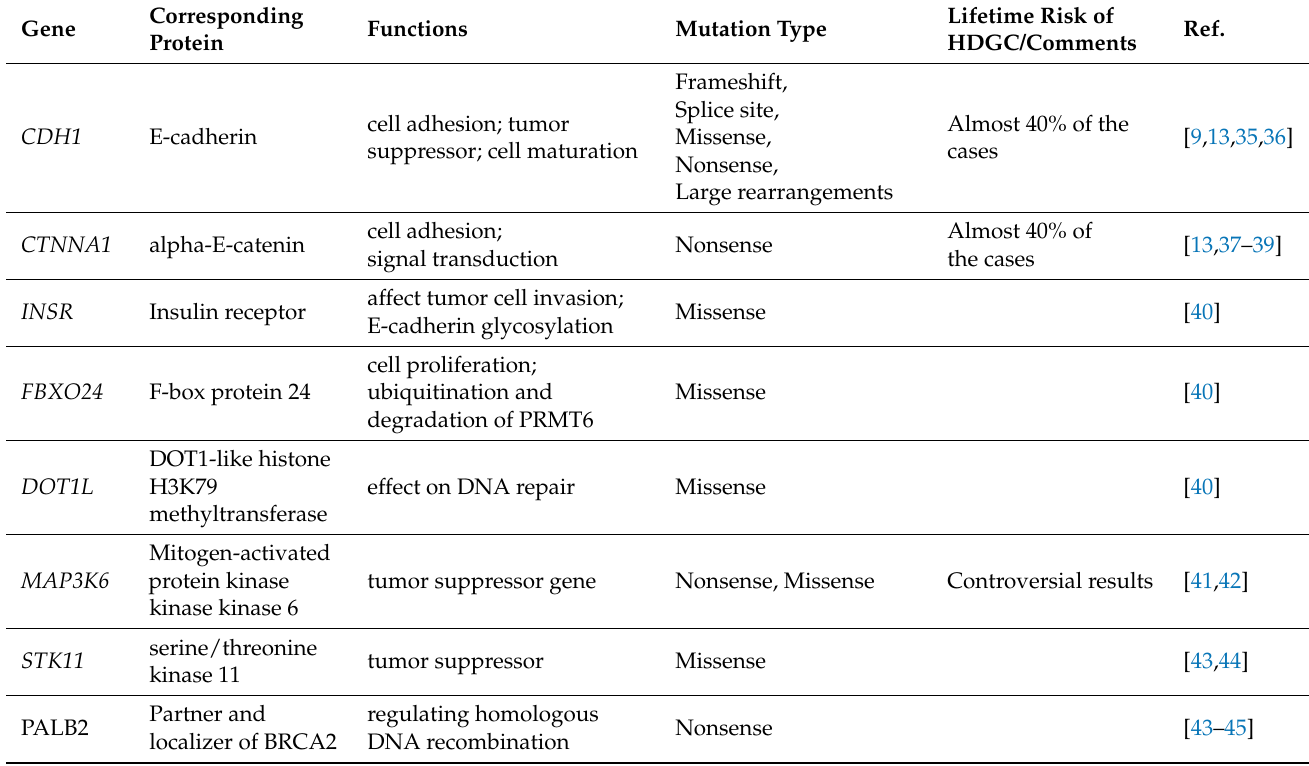
Table 1. Molecular basis of